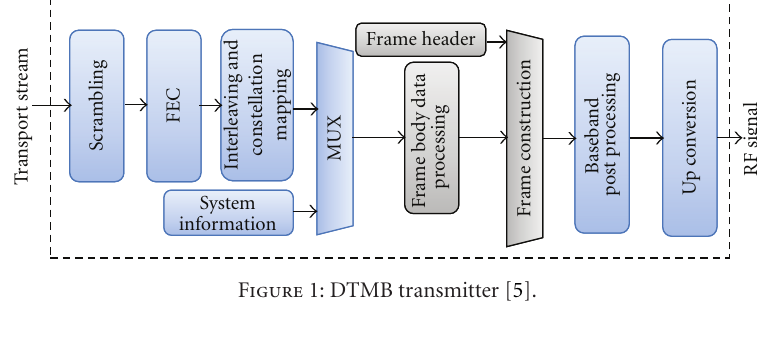
Figure 1: DTMB transmitter [5].